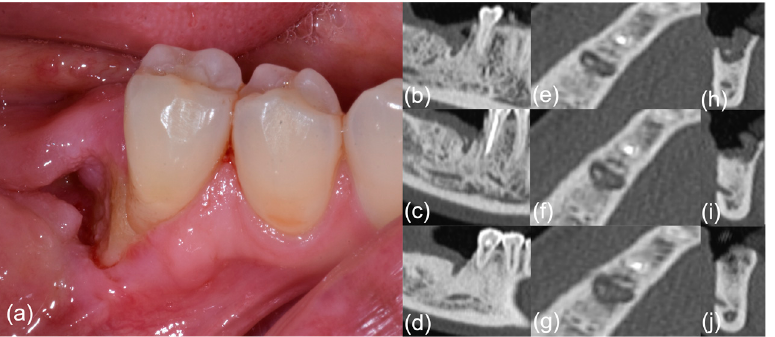
Figure 1. Patient #6, pre-treatment phase; right-side mandibular MRONJ: ( a ) clinical view; ( b – j ) computed tomography scan sections.